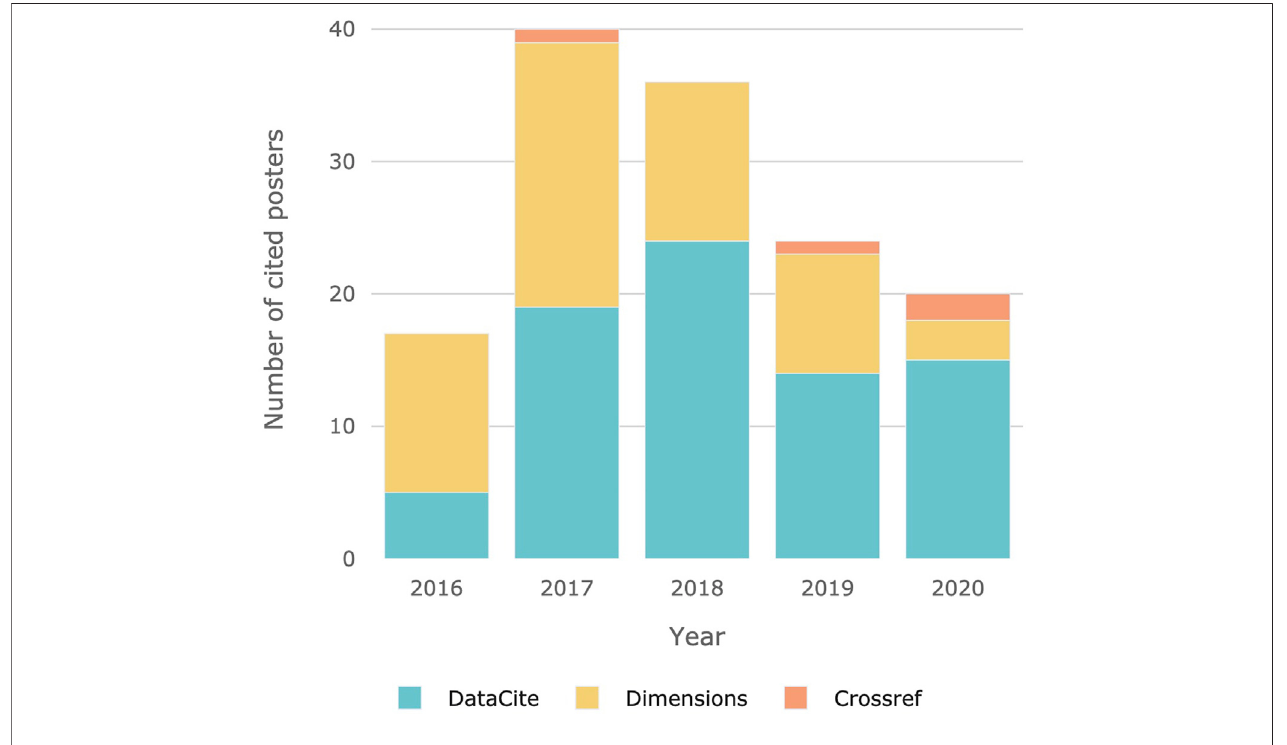
FIGURE 1 | Cited posters for each data repository.